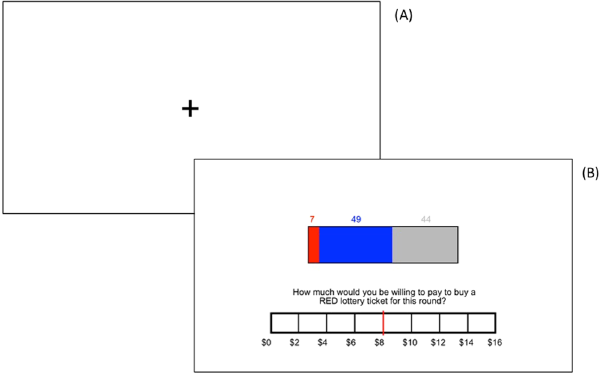
Figure 1. Ambiguity Task Diagram. After a brief fixation period ( A ), participants were presented with a virtual “bag” of exactly 100 poker chips, all of which are colored either red or blue. On each trial, participants receive partial information about the number of red (winning) and blue (losing) chips. Participants were asked to indicate their willingness to pay (WTP) for a red ticket ( B ). In this sample trial, there are 7 red (winning) chips visible, 49 blue (losing) chips visible, and 44 chips that are not visible and thus not known to the participant. Participants selected a response to the question by moving a marker across the response